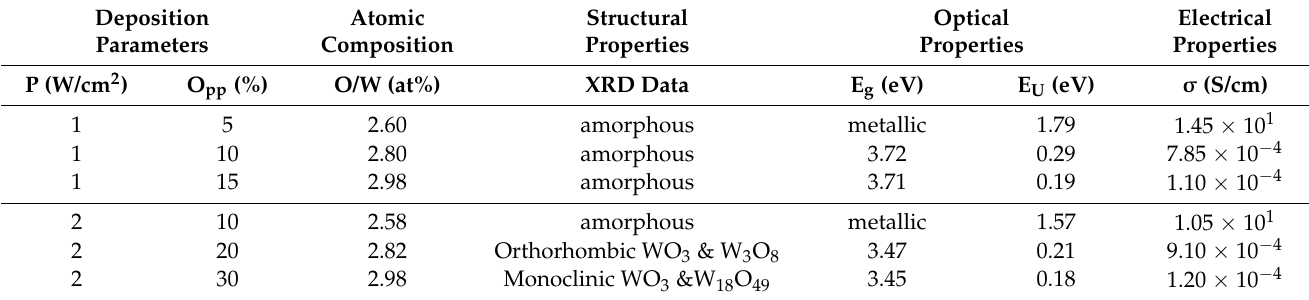
Table 1. Summary of deposition parameters and main characteristics of sputtered WO 3 − x thin